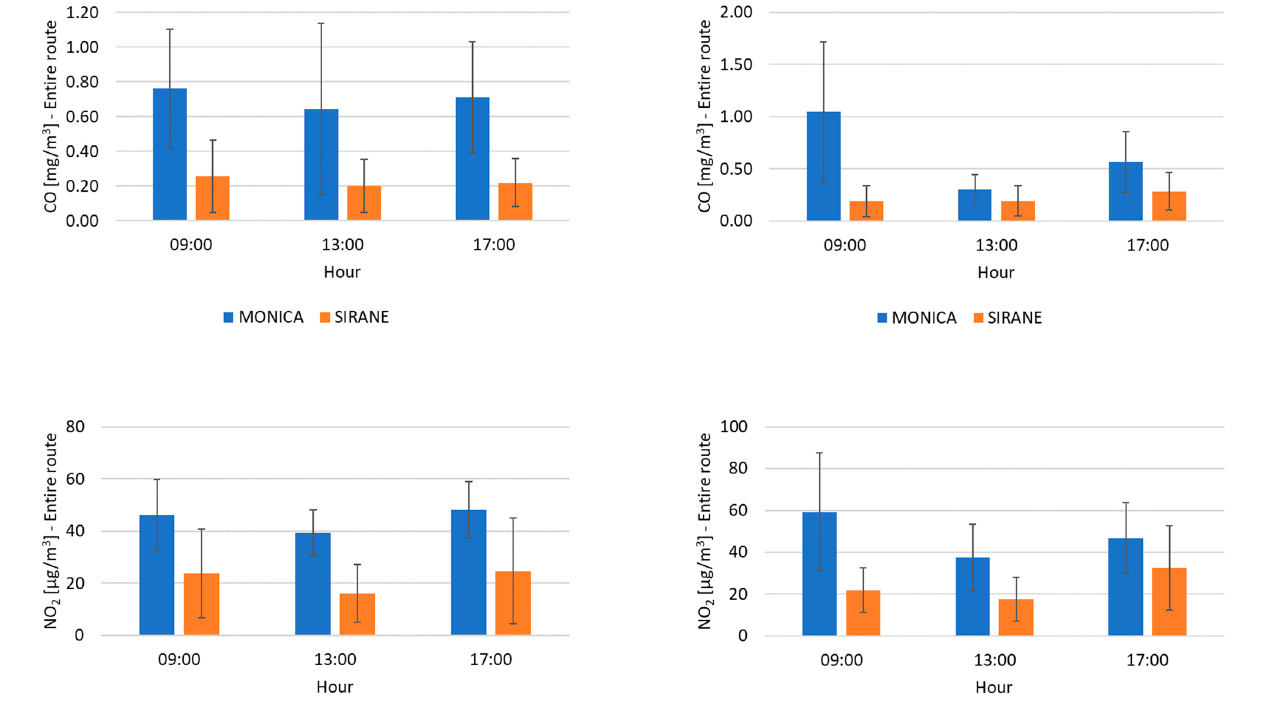
Figure 6. Comparison between the average measured and estimated concentrations of CO and NO 2 pollutants, by aggregating data spatially distributed along the entire monitoring route and for each monitored hush hour.